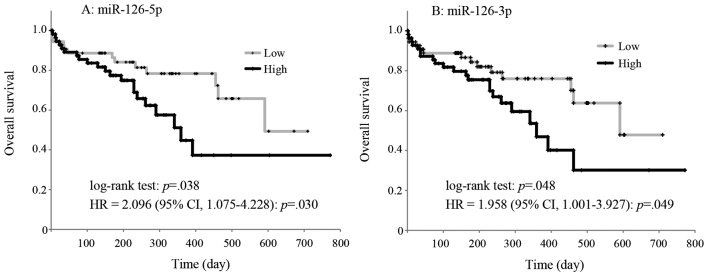
Kaplan-Meier overall survival curves for patients with AML according to the low and high expression of miR-126-5p and miR-126-3p. Kaplan-Meier plots showing estimates of overall survival probabilities grouped based on the miR-126-5p expression levels in a completely independent set of 109 AML patients. (A) The black line curve represents the samples with high (above median, 2−ΔΔCq value >1.1×10−4, n=55) miR-126-5p expression levels, whereas the dotted line curve corresponds to the samples with low (below median, 2−ΔΔCq value <1.1×10−4, n=54) miR-126-5p expression levels. (B) The black line curve represents the samples with high (above median, 2−ΔΔCq value >2.0×10−4, n=54) miR-126-3p expression levels, whereas the dotted line curve corresponds to the samples with low (below median, 2−ΔΔCq value <2.0×10−4, n=54) miR-126-3p expression levels. Comparisons between each group were performed with the log-rank test. Cox proportional hazards models also estimated a significantly higher HR of miR-126-5p and miR-126-3p in the high group: miR-126-5p: HR=2.096 (95% CI, 1.075–4.228), p=0.030 and miR-126-3p: HR=1.958 (95% CI, 1.001–3.927), p=0.049. In the Cox proportional hazard regression model, the ‘miR-126-5p x miR-126-3p’ interaction was not significant (p=0.73). CI, confidence interval; AML, acute myeloid leukemia; HR, hazard ratio.